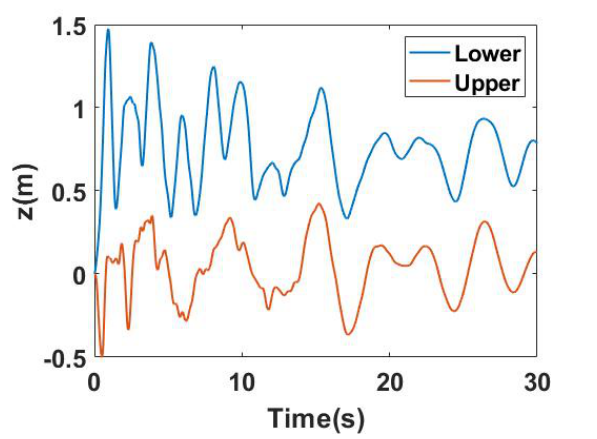
Figure 18. Motions of the upper node and the lower node with respect to their original location.